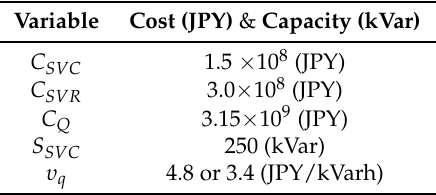
Table 2. Parameters for the comparison case.